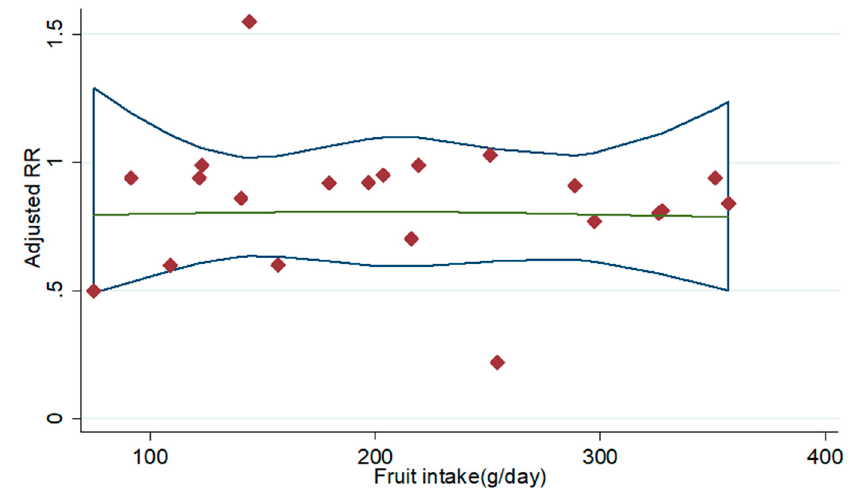
Figure 4. Dose-response analysis for the curvilinear association between intakes of fruit in former smokers and lung cancer risk. Abbreviations: RR—relative risk.